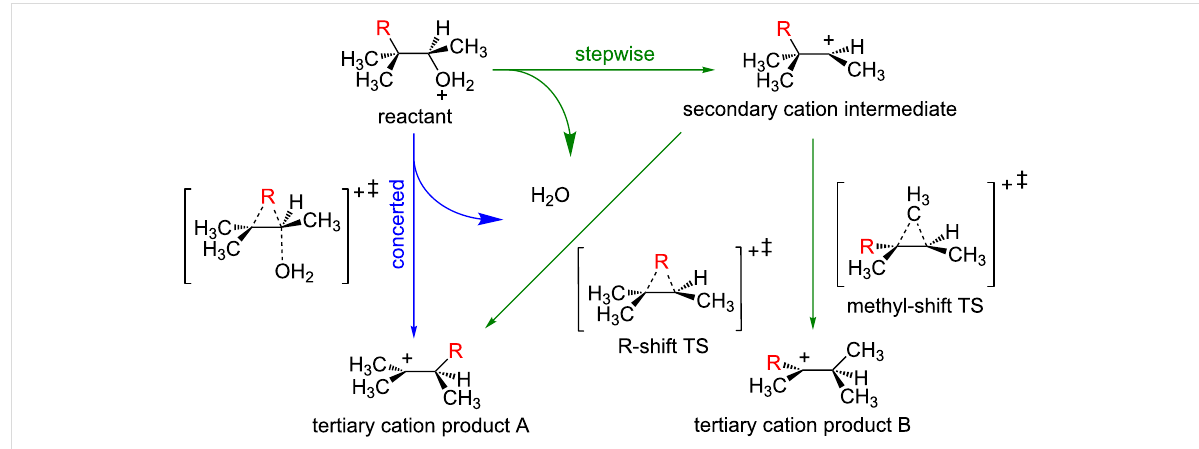
Figure 5: The reaction mechanisms of interest in the PES and dynamics studies of Dupuis and co-workers (R = CH 3 ) and de Souza et al. (R = CH 3 , Et, iPr). Note: in the case of R = CH 3 , tertiary cation products A and B are equivalent. Adapted from Dupuis and co-workers and de Souza et al.